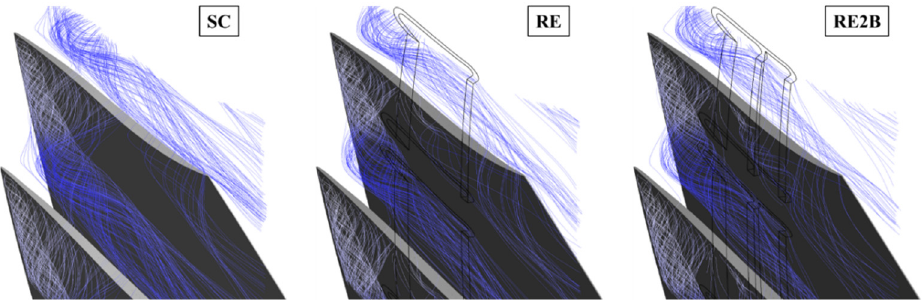
Figure 6. Streamlines of tip leakage vortex at near-stall condition.